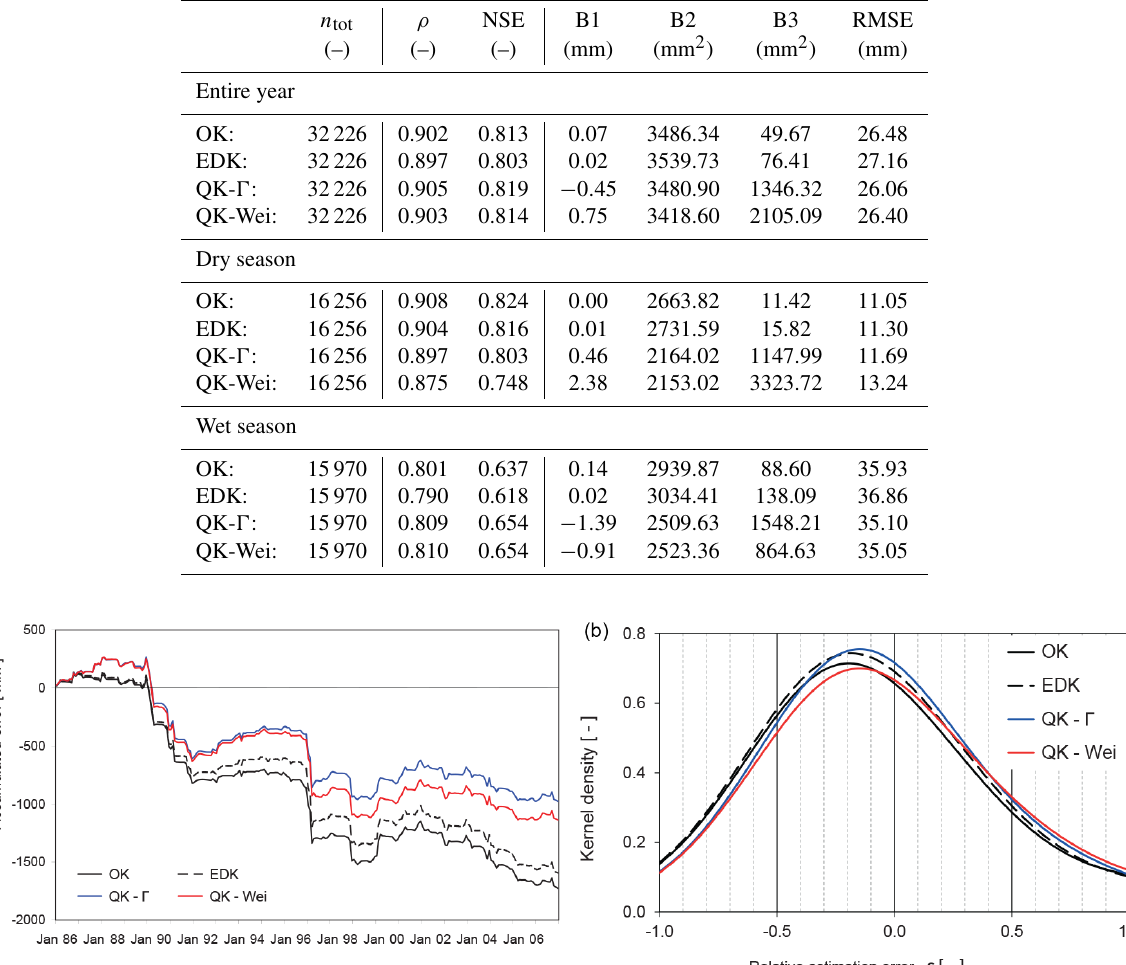
Table 1. Summary results from the cross-validation of the estimator Z ∗ for the 12 calender months of the entire year, and split into dry (calender months: 4–9) and wet (calender months: 1–3 and 10–12) season.